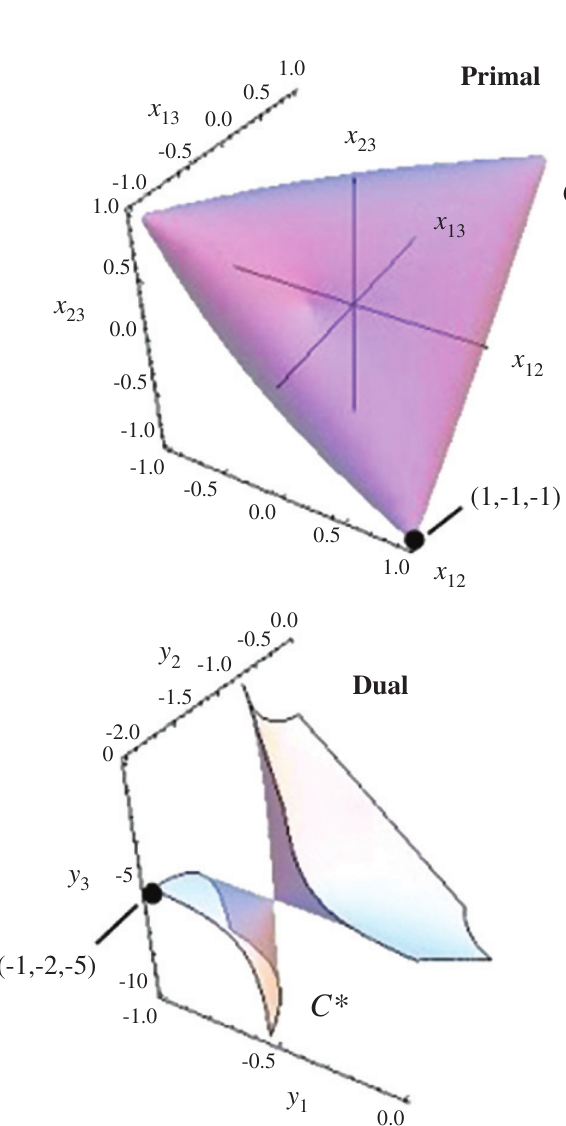
Figure B1: Binary QP numerical example